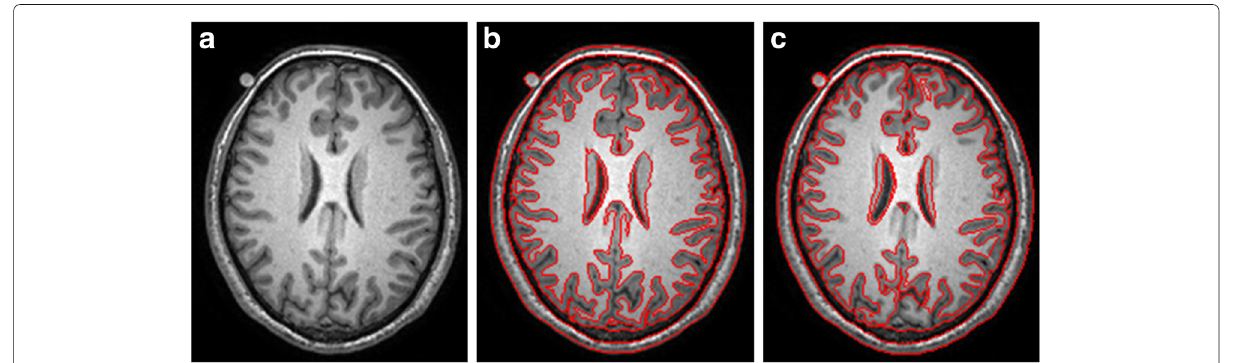
Fig. 9 Comparison with the work [31]: a original MR image, b result via [31], and c result based on our method